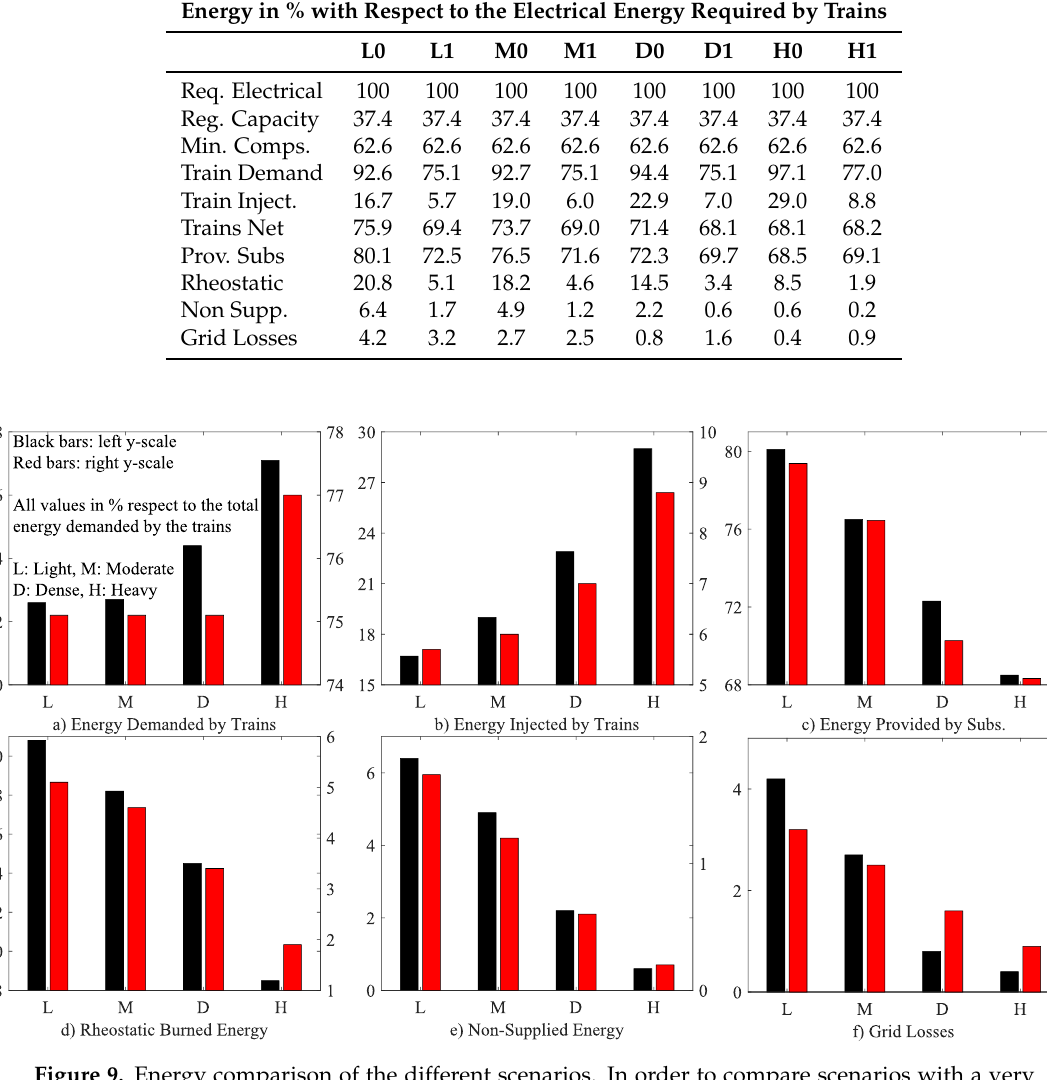
Figure 9. Energy comparison of the different scenarios. In order to compare scenarios with a very different number of trains, all the energy values have been expressed in percentage referring to the total energy demanded by the trains in each scenario. This value can be found for each scenario in the first row of the Table 4. Black bars represent the cases without energy storage, and they are associated with the y-scale on the left. Red bars represent the cases with energy storage, and they are associated with the y-scale on the